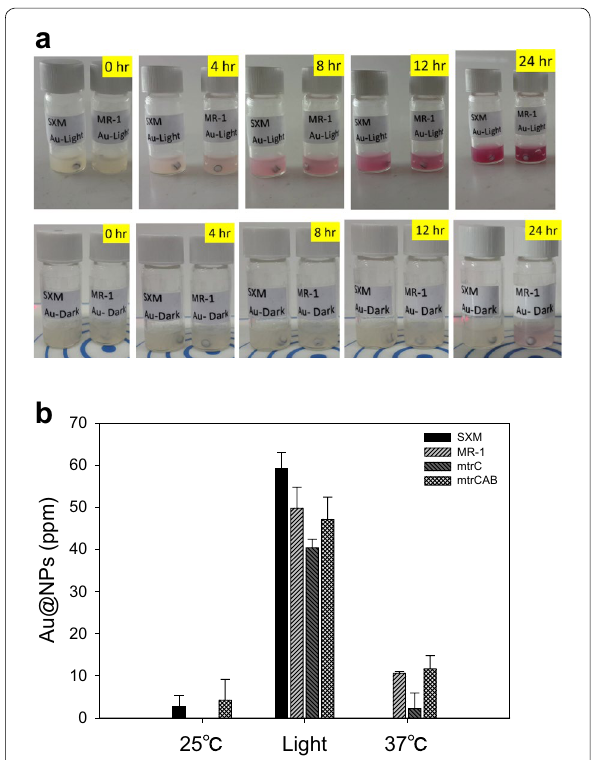
Fig. 3 Effect of light on Shewanella in Au@NP formation when immersed in 300 ppm Au 3 + . a Photos of Shewanella placed under light (top) and in the dark (bottom) within 24 h. b Amount of Au@NPs produced by Shewanella at 25 °C, light effect, and 37 °C for 24